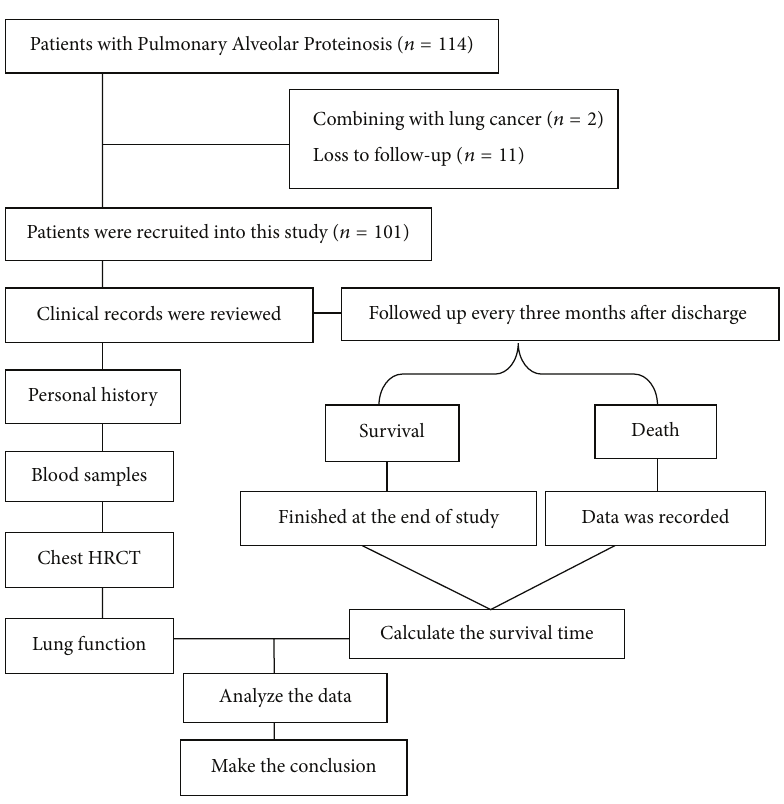
Figure 1: The detailed procedure of screening patients who were recruited to participate in this